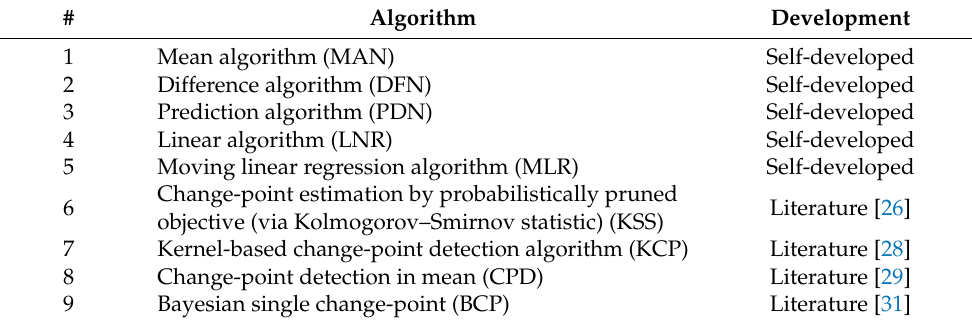
Table 2. Overview of the nine algorithms for determining the pressure drop time points.